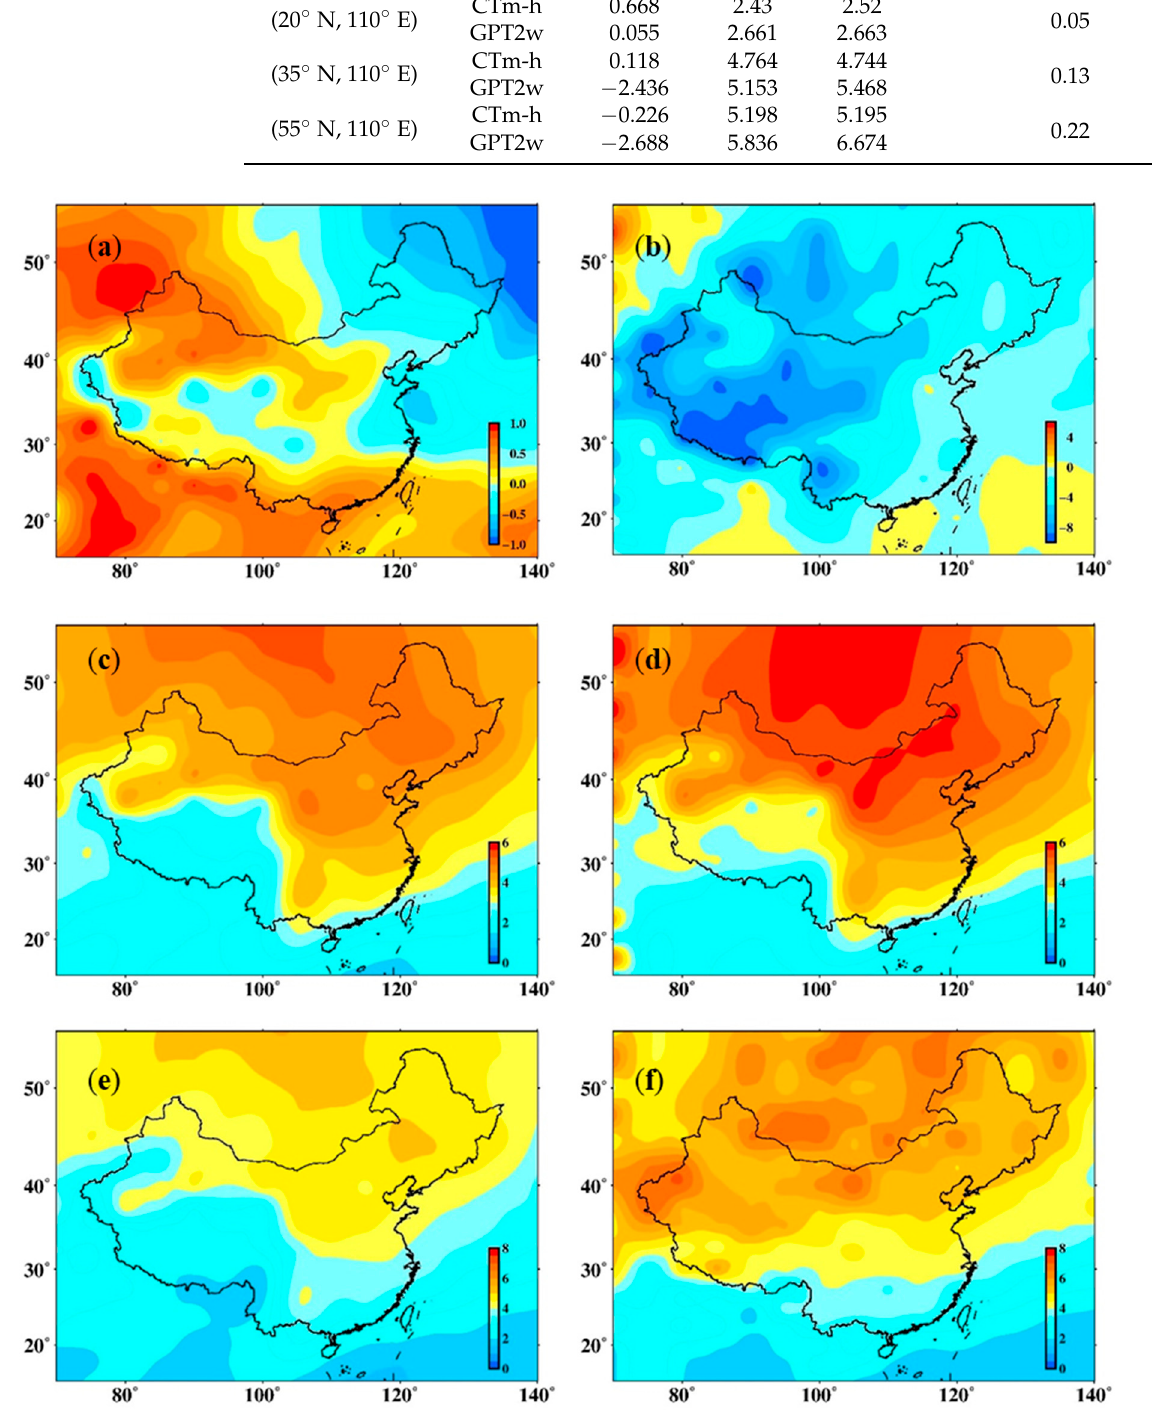
Figure 9. The average bias ( a ), SD ( c ), and RMS ( e ) distribution of CTm-h; the average bias ( b ), SD ( d ), an RMS ( f ) distribution of GPT2w. Table 2. Precision statistics of CTm-h and GPT2w models (K).